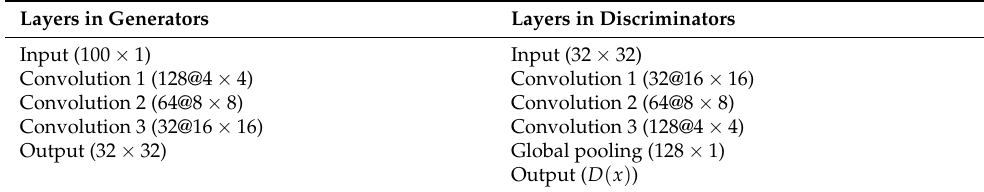
Table 4. Structures of generators and discriminators.